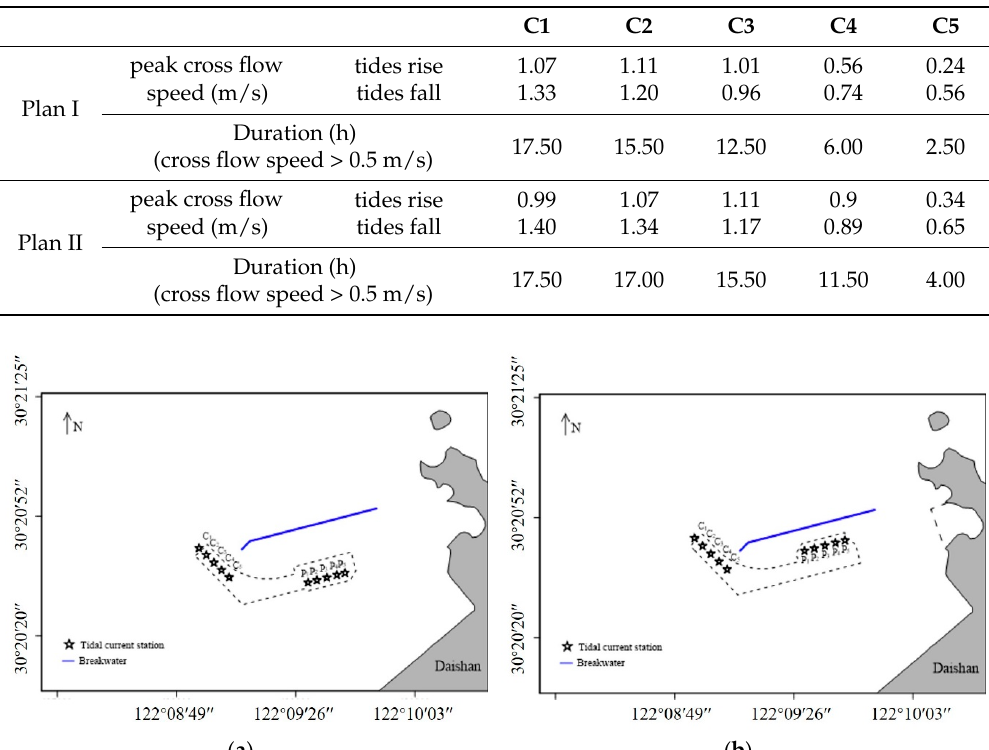
Table 6. Cross flow speed statistics after engineering.